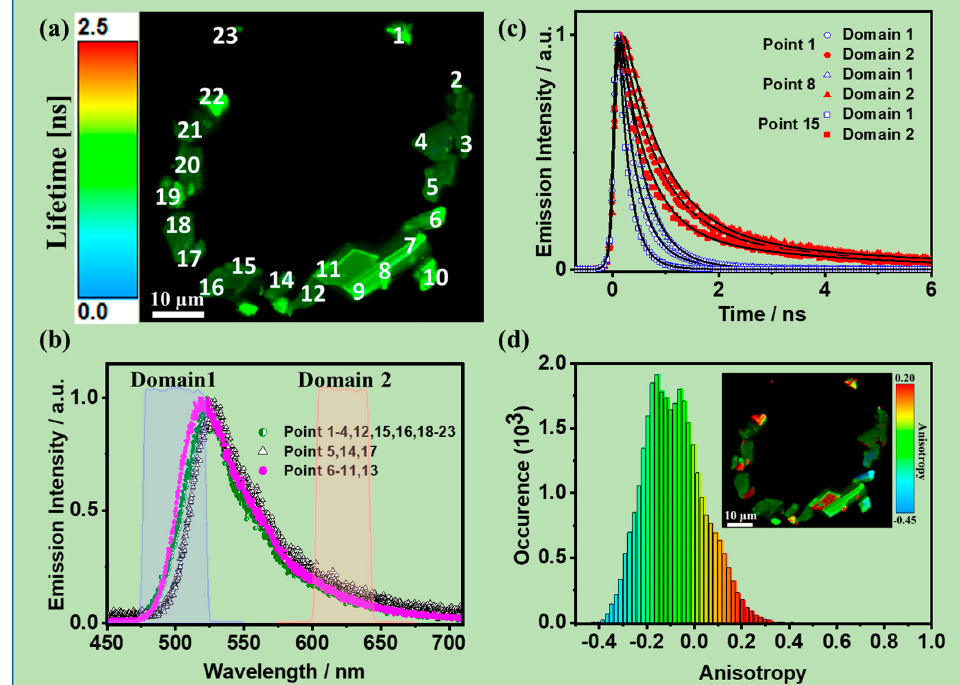
Figure 8. ( a ) FLIM of CPHATN-1a crystals. ( b ) Emission spectra of the crystals (or sites) shown in ( a ). ( c ) Emission decays at selected spectral ranges as indicated in ( b ). ( d ) Histogram of the emission anisotropy of the crystals (inset). Reproduced with permission from the American Chemical Society, 2019.